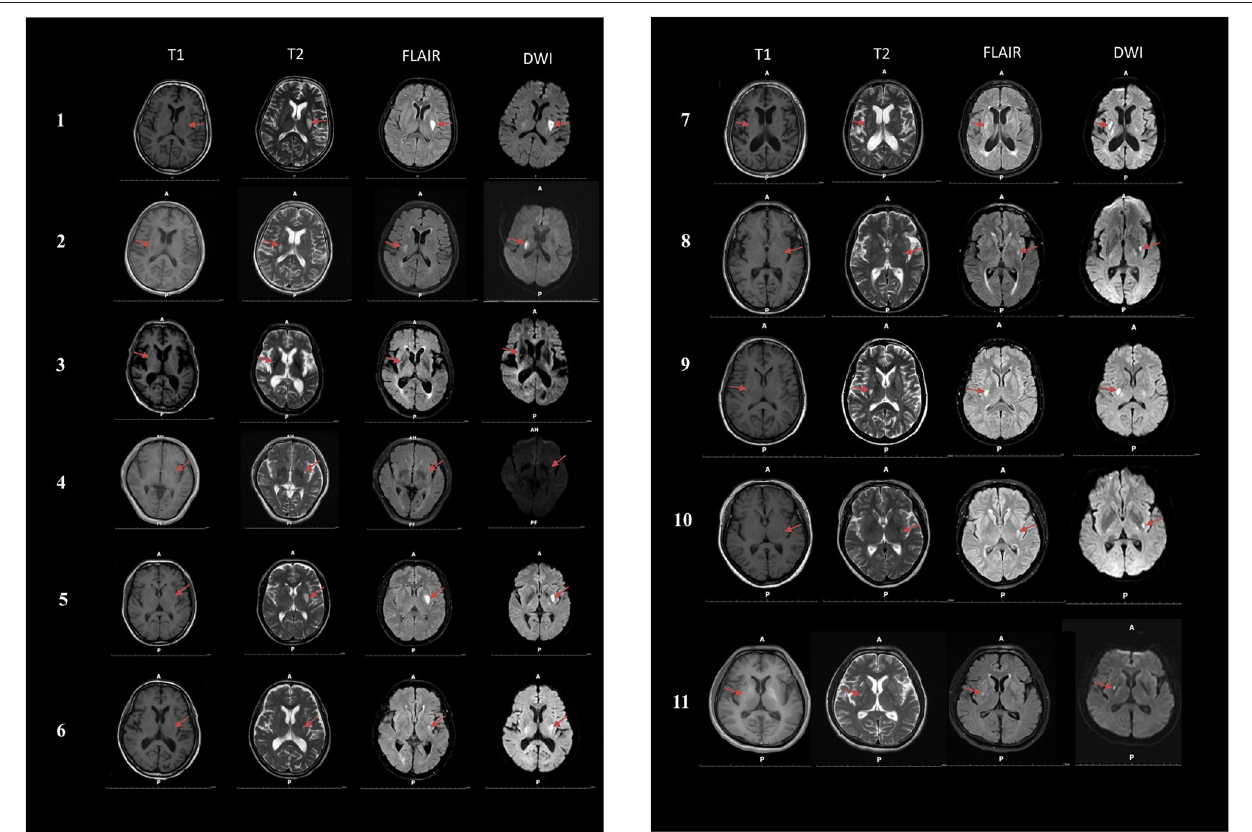
FIGURE 2 | Magnetic resonance imaging (MRI) was performed on 11 smokers with dorsal striatum damage. T1, T1-weighted images; T2, T2-weighted images; FLAIR, Fluid attenuated inversion recovery; DWI, Diffusion weighted imaging.